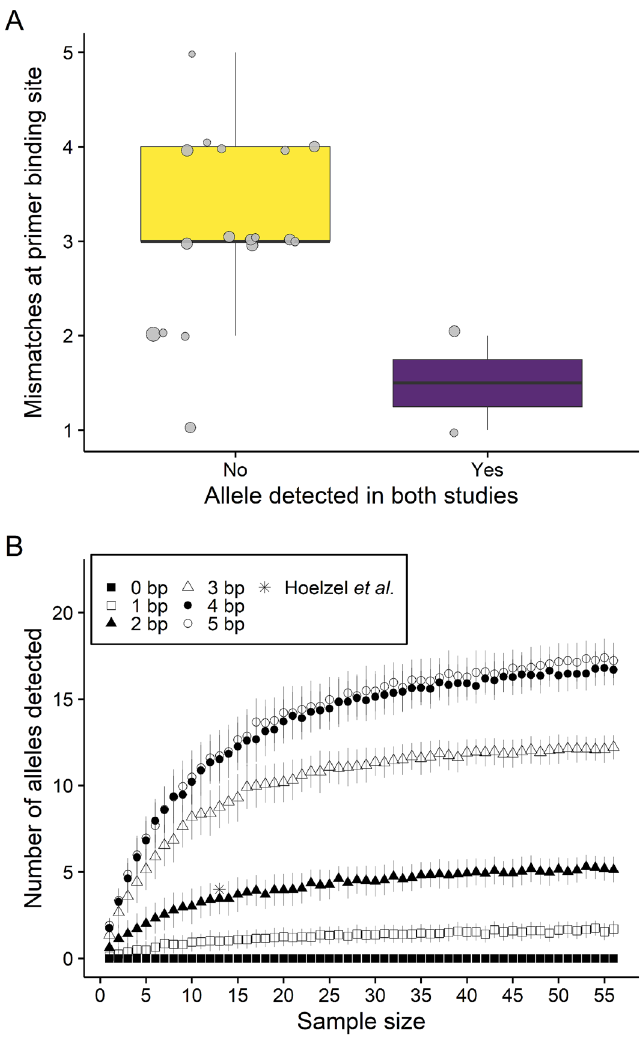
Figure 5. An exploration of possible factors affecting the inference of ArGa-DQB allelic diversity. ( A ) Comparison of the number of nucleotide mismatches at the primer binding sites of Hoelzel et al. 70 . For 17 alleles that uniquely amplified in the current study versus two alleles that were detected in both studies. The box plots show the median and interquartile range, with the whiskers indicating the 95% confidence intervals. Individual alleles are shown with circle size in proportion to allele frequency. ( B ) Allele detection curves computed by randomly sampling the empirical genotypes with replacement (999 replicates each) for sample sizes ranging from one to 56 individuals (see “Materials and methods” section for details). Results are shown separately for different threshold values used to classify alleles based on the number of nucleotide mismatches at the primer binding sites. Shown are the mean and standard deviation of the number of detected